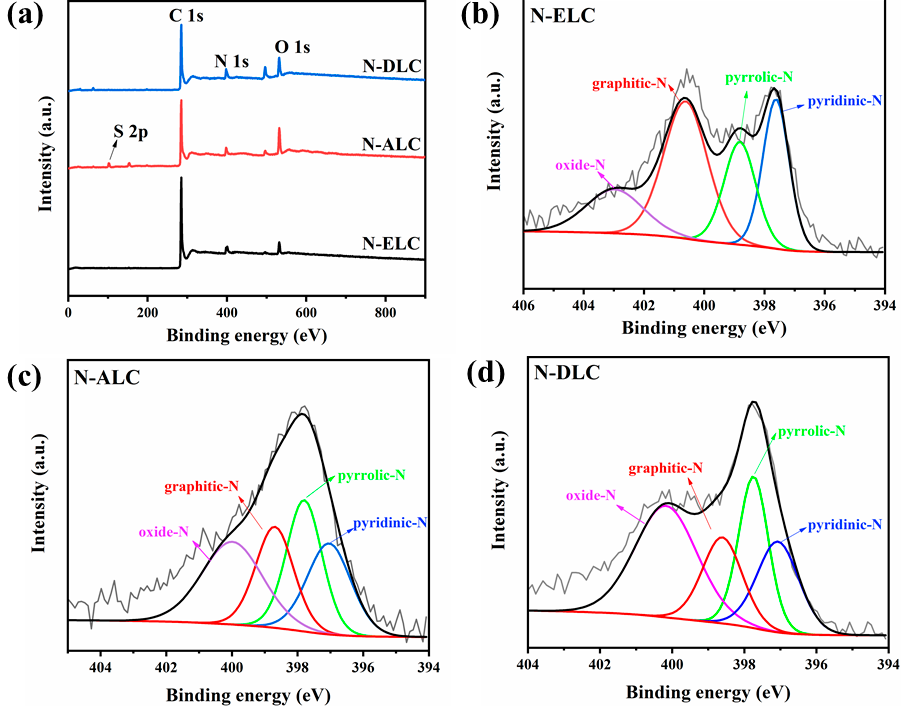
Figure 5. ( a ) XPS full − scan spectra of different lignin carbon materials, and N 1s spectra of ( b ) N − ELC, ( c ) N − ALC, and ( d ) N − DLC. Table 2. N contents and N types of different lignin